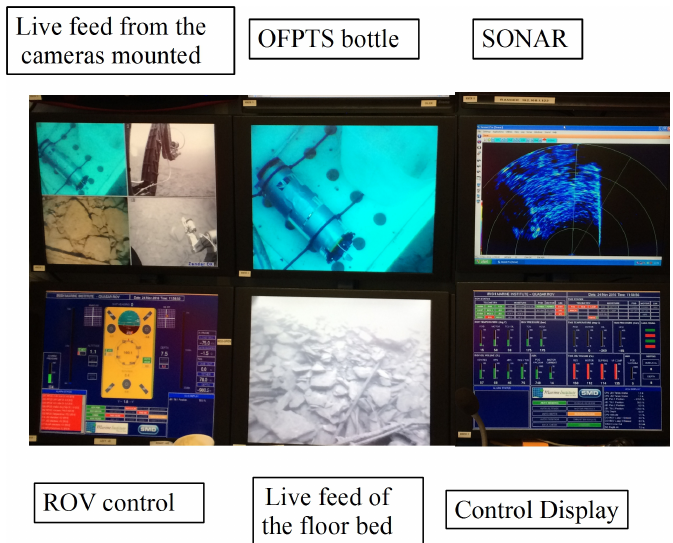
Figure 5. ROV (Holland1) on the floor bed which was controlled from the control